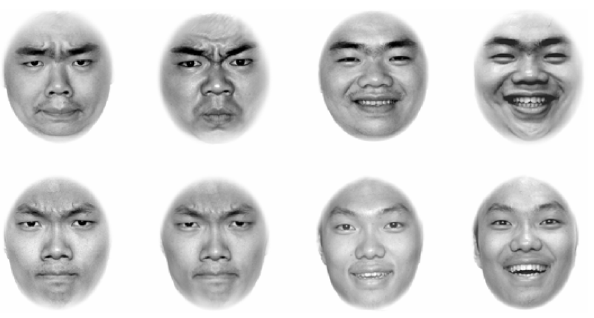
FIGURE 4 | Eight face photos used in Experiment 4. The top row of the four photos comes from Model C, and the bottom row of the four photos comes from Model E. In both the top and bottom rows, the first two photos show angry expressions, with a small difference in emotional intensity between them, and the last two photos show happy expressions, also with a small difference in emotional intensity between them.The discriminabilities of expressions were both high, with RT of 467 ms and 480